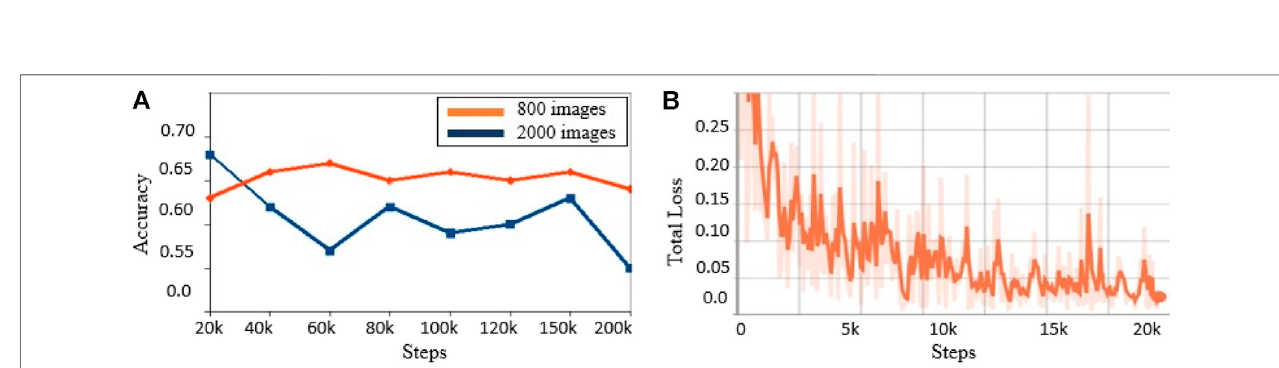
FIGURE10| (a)FasterR-CNNmodelaverageprecisionvaluesonthetestdatafordatasetsize800and2000subimagesatdifferenttrainingsteps.(b)Totallosses for the Faster R-CNN best model for dataset size 2000 subimages up to 20 K training steps.